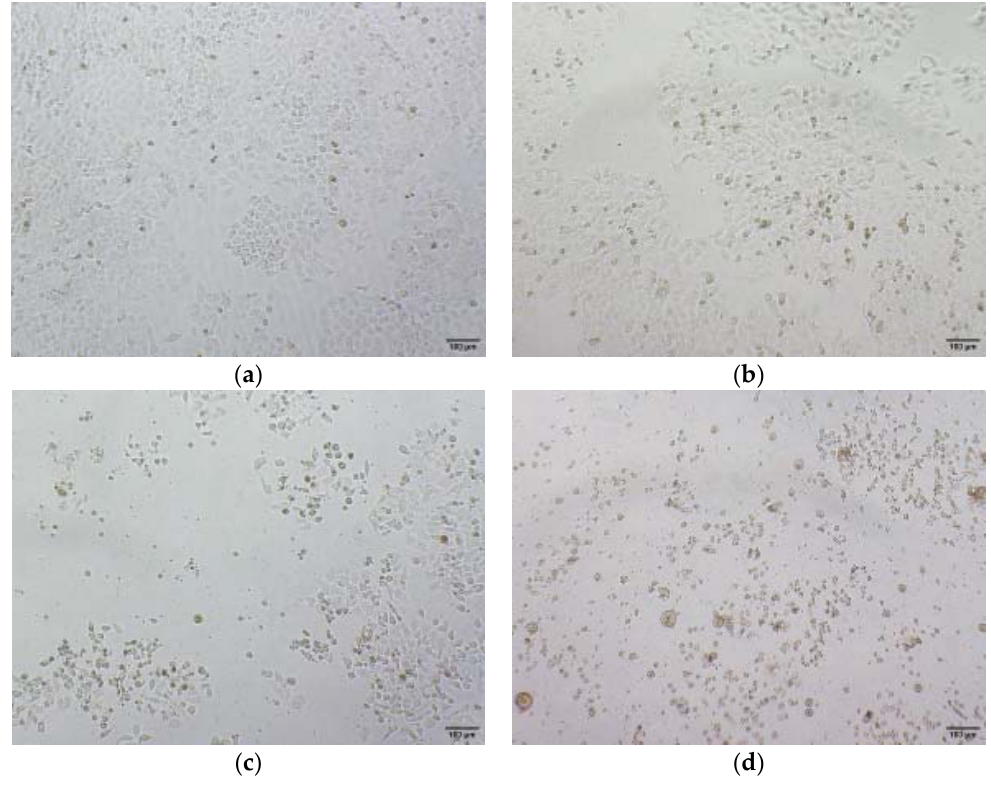
Figure 2. Proliferation of HepG2 cells by compound 1 at different concentrations: ( a ) HepG2 negative control; ( b ) 6.25 μ M; ( c ) 25 μ M; and ( d ) 50 μ M.